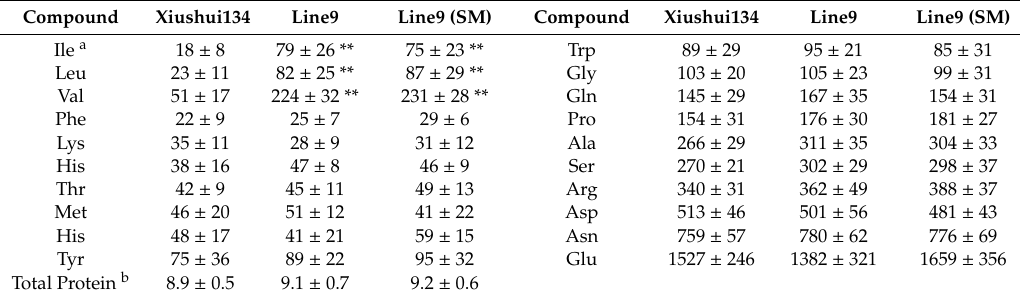
Table 4. Total protein and free Amino Acids in the Xiushui134 and Line9 seeds.